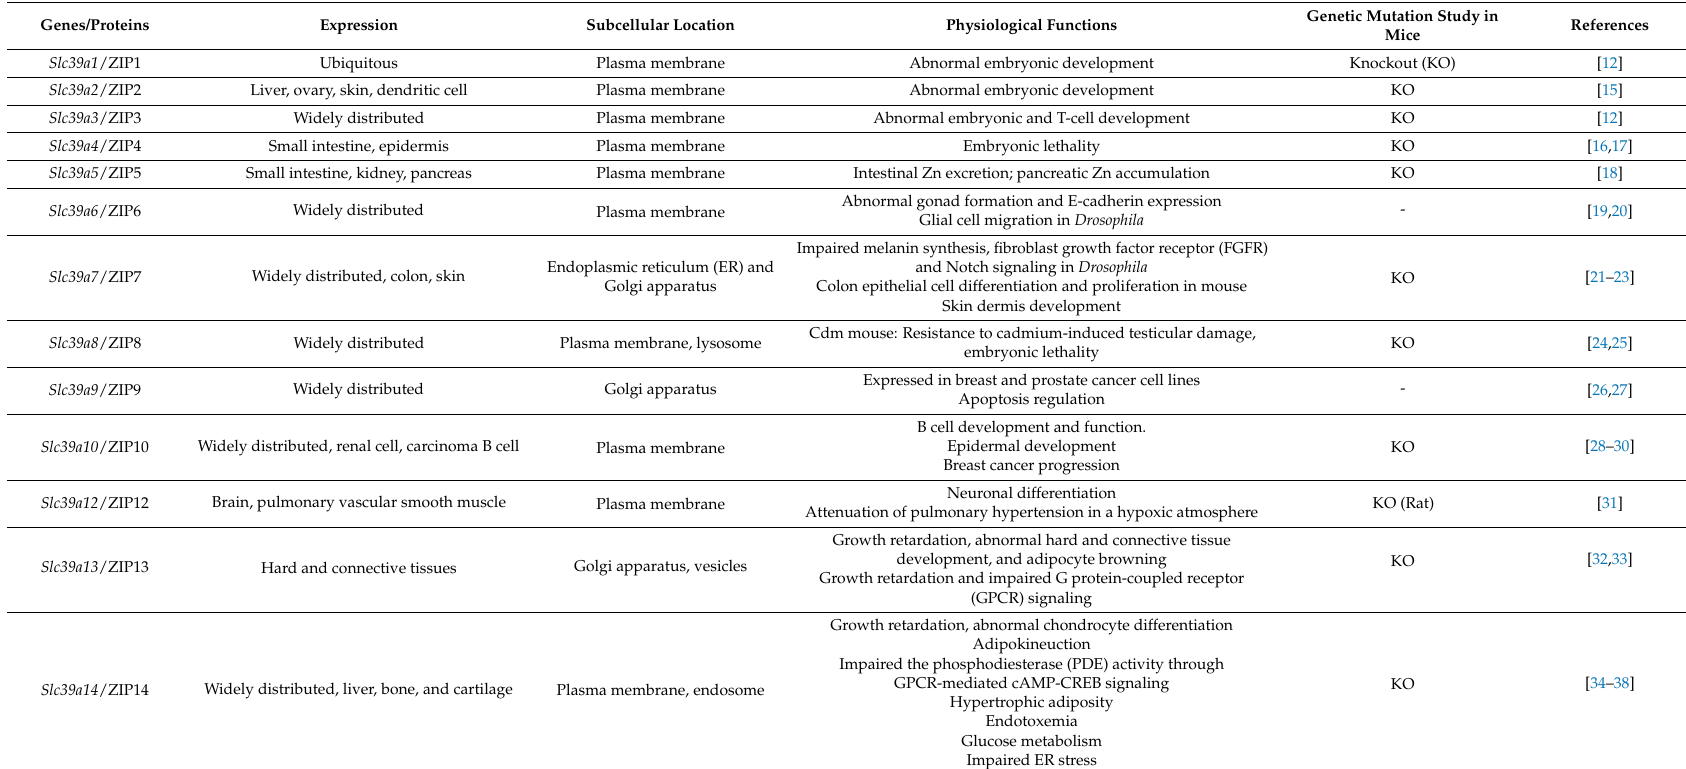
Table 1. Physiological properties of SLC39A/ Zrt- and Irt-like protein (ZIP)